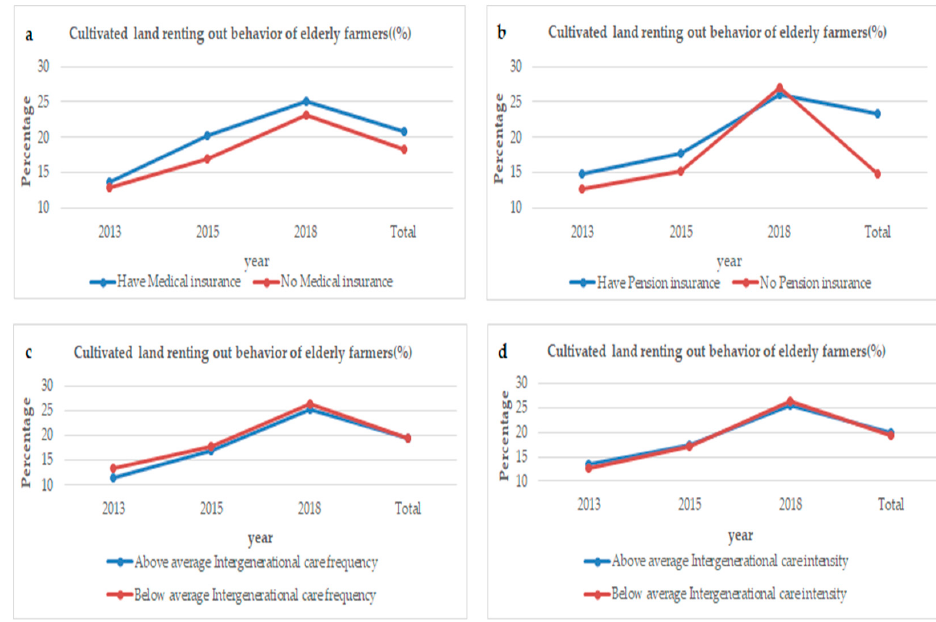
Figure 4. Cultivated land renting out behavior of elderly farmers under different circumstances (%). Table 2. Well-being of elderly farmers under different intergenerational care situations